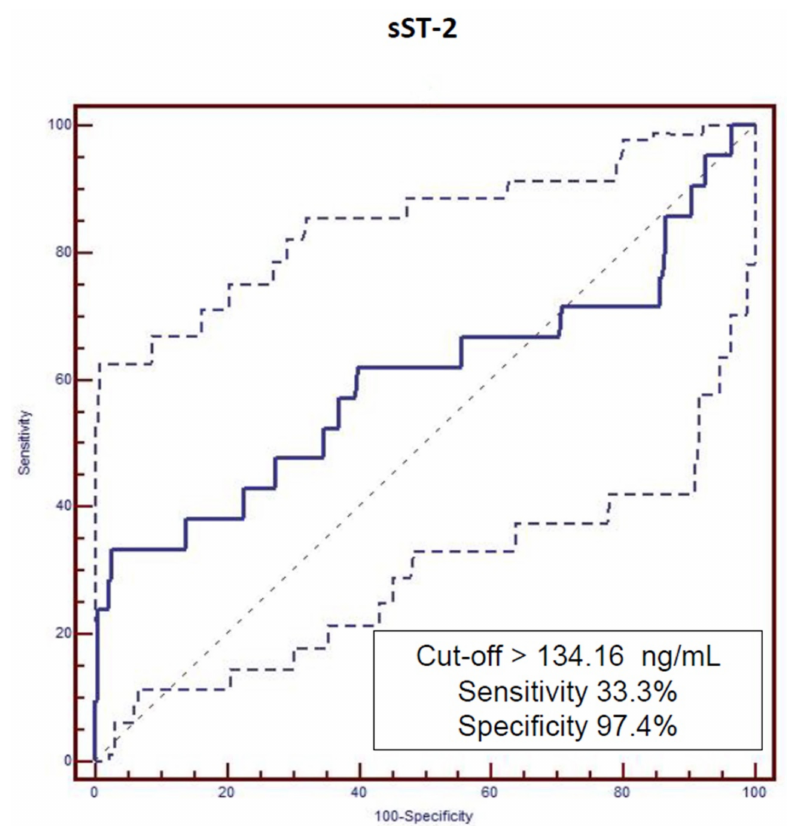
Figure 4. Major adverse cardiovascular events (MACE) cut-off values of soluble suppression of tumorigenicity-2 (sST-2) estimated by ROC analysis.